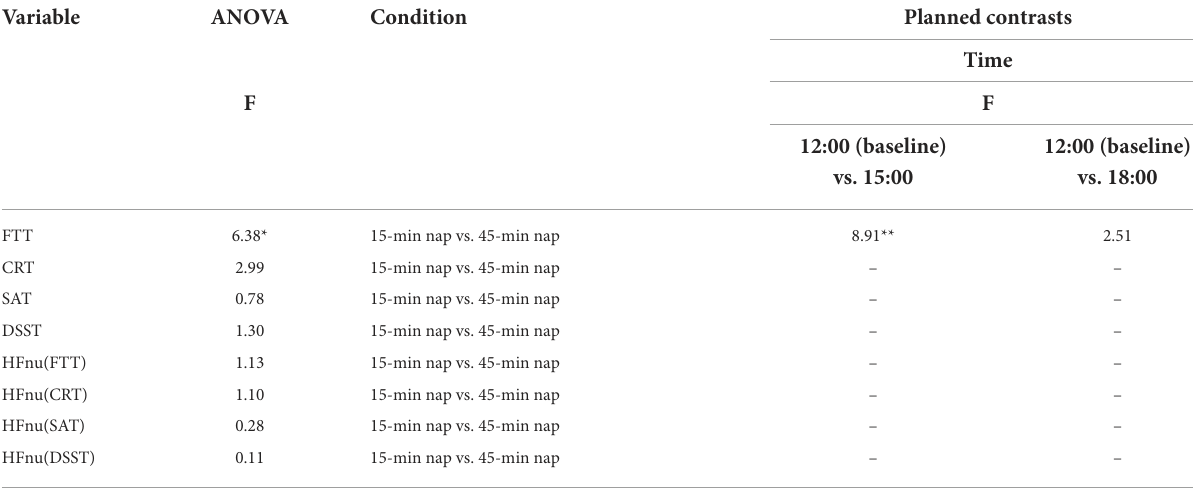
TABLE 5 Two-way ANOVA and planned within-subjects contrasts for time (pre-nap vs. post-nap time) by condition (15-min vs. 45-min) for the dependent variables. Variable ANOVA Condition Planned contrasts